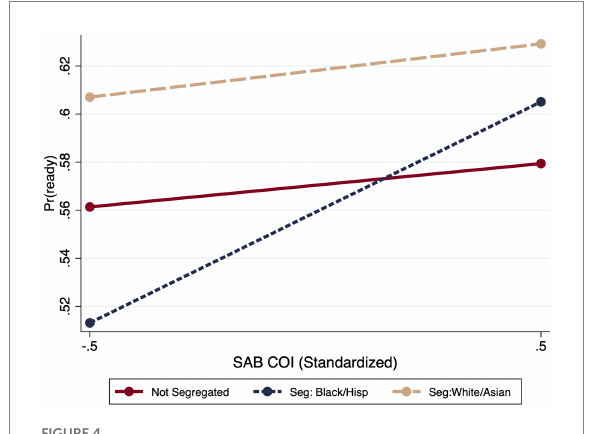
FIGURE 4 Predicted school readiness likelihood for average student, by segregation level (share).